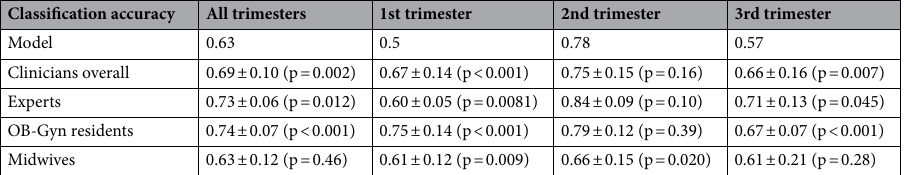
Table 2. Classification accuracy on a subset of 24 randomly selected ultrasound images of the model compared to mean and standard deviation of classification accuracy distributions for different groups across trimesters. P-values of t-test are reported in parentheses, using a one-sided, one-sample t-test.